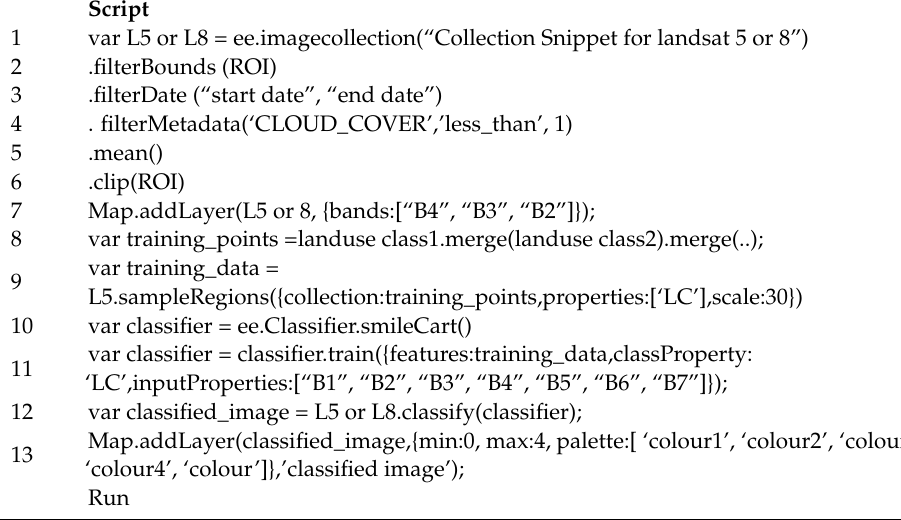
Algorithm 2: “Image retrival of Landsat 5 or 8, False color composite image preparation and LULC map preparation for